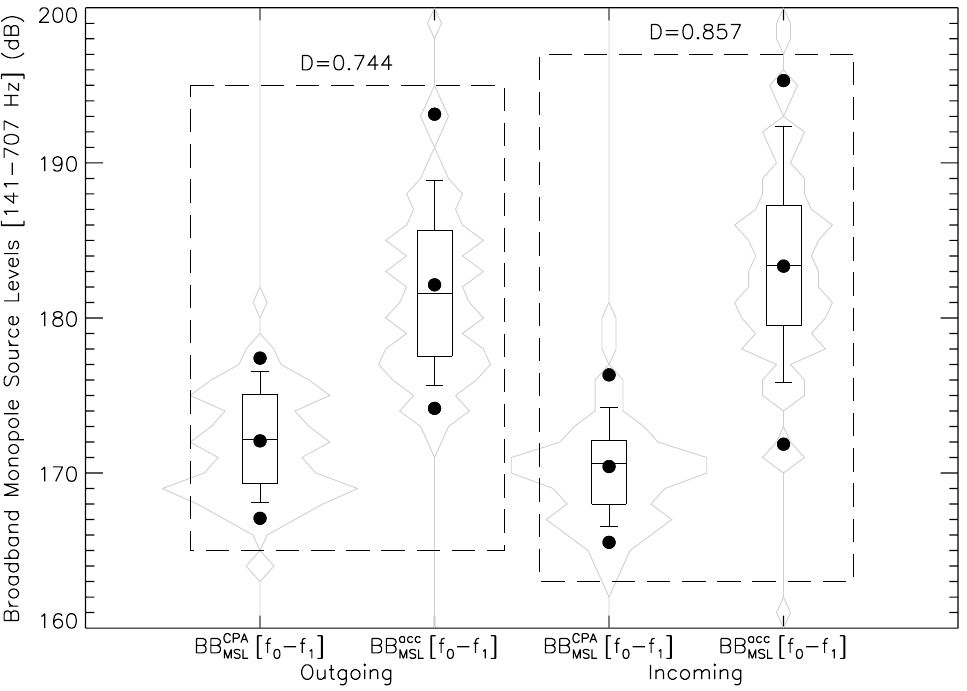
Figure 6. Whisker plots of the BB CPA MSL [ f 0 − f 1 ] and BB acc MSL [ f 0 − f 1 ] distributions provided in Table 5. Percentiles are shown, from bottom to top, at 5% (dot), 10%, 25%, 50%, 75%, 90%, and 95% (dot). The central dot gives the mean of the distribution. Violin plots tracing out the shape of each distributions are added. The KS-statistic D between CPA and acceleration/deceleration measurements is fairly close to 1 for both outgoing and incoming trips, hence suggesting a genuine statistical difference in radiated source noise levels between both operational